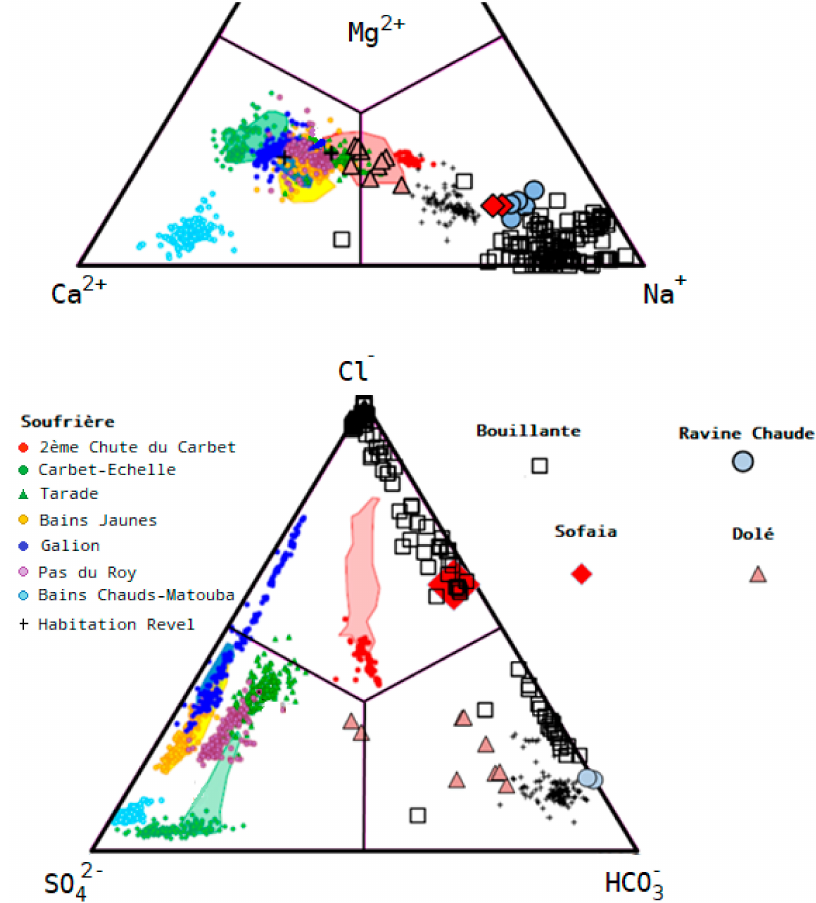
Figure 7. Triangular diagrams reporting the cationic and anionic chemistry of hot springs in the different sectors of the Basse-Terre Island, Guadeloupe. Modified from Villemant et al. 2014 [45], with addition of data for Bouillante, Ravine Chaude, Sofaia, Dol é from Bourdon et al. (2008)